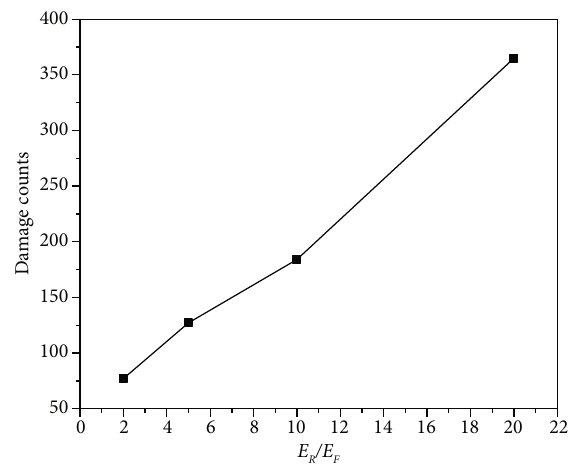
Figure 10: Damage counts under di ff erent retaining wall sti ff ness.